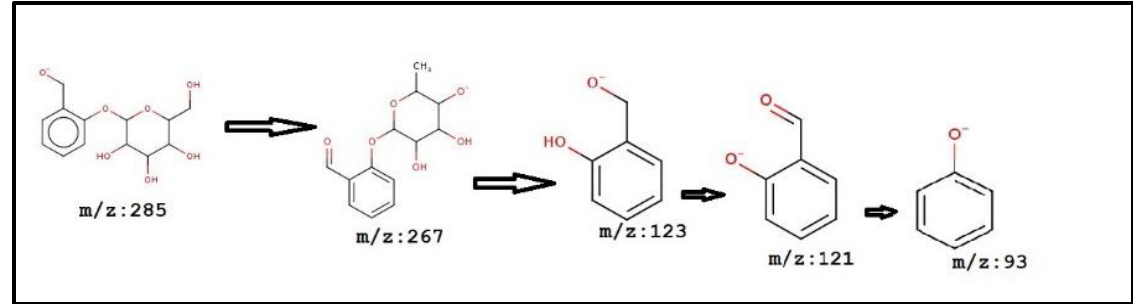
Figure 16. Salicin fragmentation pathway.